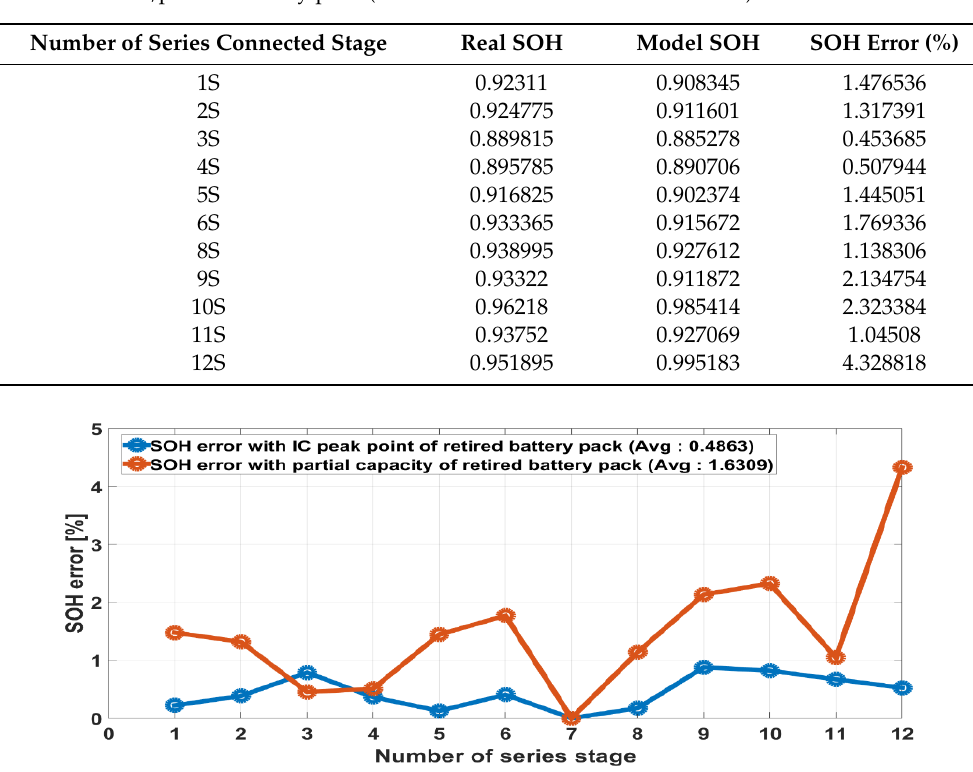
Figure 22. Comparison between the linear regression model based on the IC curve peak point of cell no. 1 and a real SOH based on the IC curve peak point of the 12 series ‐ connected stages of the retired series/parallel battery pack. Table 4. Numerical results for the comparison between the linear regression model based on the partial capacity of cell no. 1 and a real SOH based on the partial capacity of the 12 series-connected stages of the retired series / parallel battery pack (SOH error = Real SOH − Model SOH).